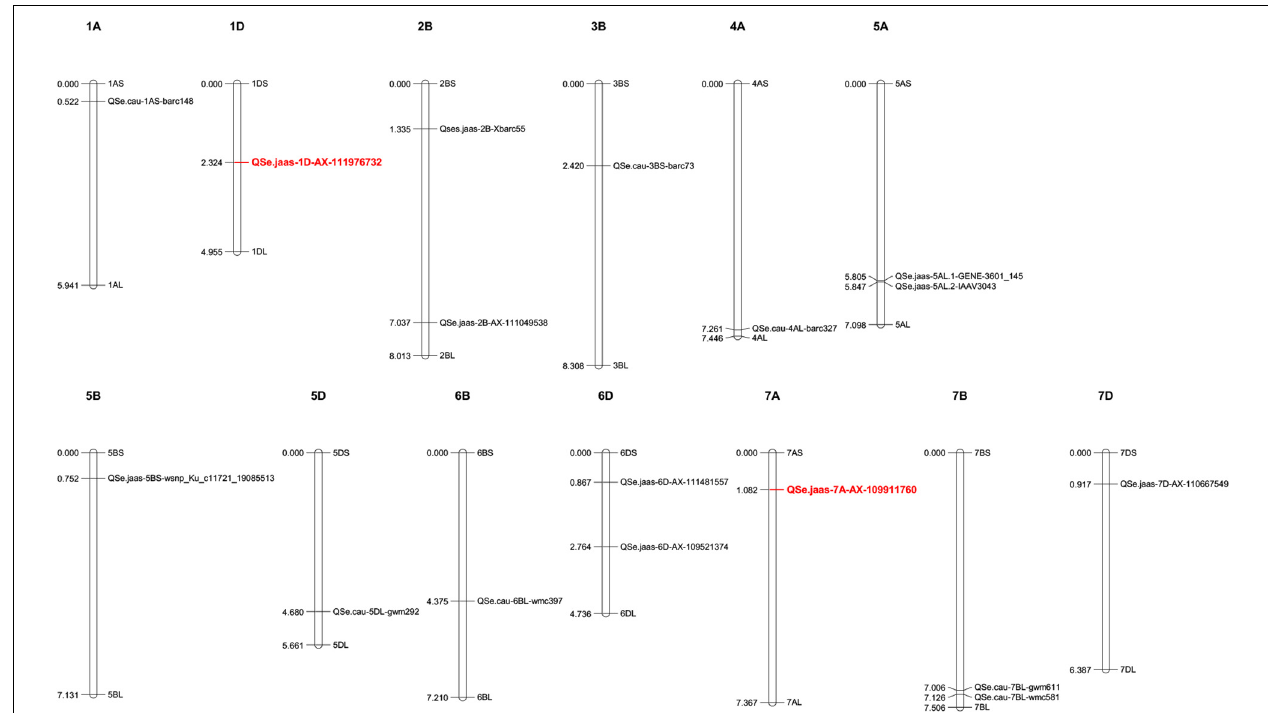
FIGURE 4 | Identified QTLs controlling wheat resistance to sharp eyespot. Molecular markers associated with Rc-resistant QTLs were collected from previous publications and searched against the JBrowse-1.12.3-release of the common wheat “Chinese Spring” genome available from the “Triticeae Multi-omics Center (http://202.194.139.32/).” Physical positions (numbers indicated on the left side of each chromosome, in units of 100,000,000 bp) were used to generate a distribution map of all the collected QTLs using Mapchart v2.32 software. Detailed information for these QTLs can be found in Table 3